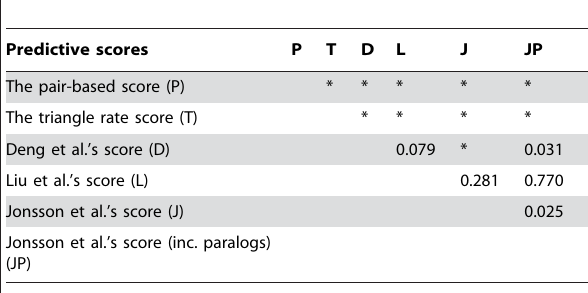
Table 4. Z-tests for AUC Comparison among Predictive Scores.